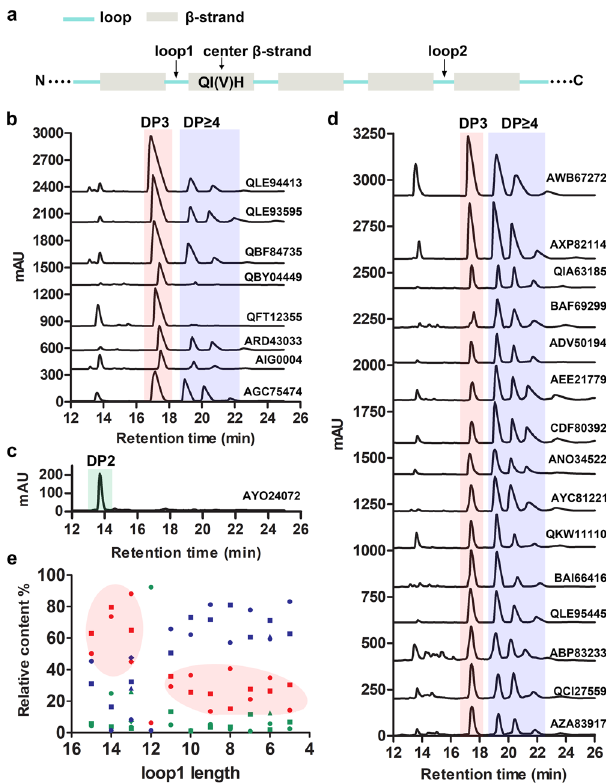
Fig. 8 The association between loop1 length and product distribution was determined. a The approach to determine the positions of loop1 and loop2 for single-domain PL7 alginate lyases. Based on the similarities in product distributions, the 24 annotated-only PL7 alginate lyases were classi fi ed into three groups and are presented in b – d . e The association between loop1 length and product distribution. The disaccharides, trisaccharides, and oligosaccharides (DP ≥ 4) are shown in green, red and blue, respectively. The circles, squares, rhombi, and triangles represent different alginate lyases sharing the same loop1